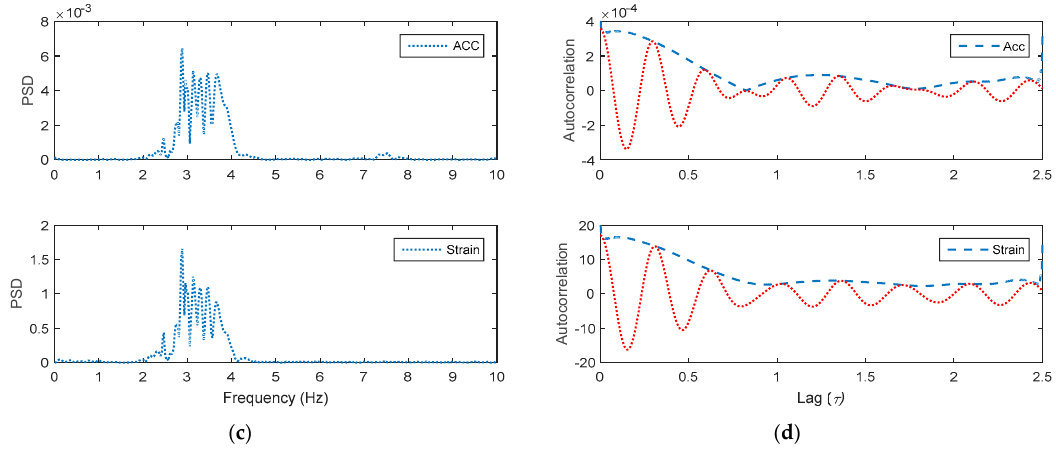
Figure 10. Frequency domain evaluation of ( a ) time–frequency, ( b ) time–phase, ( c ) fast Fourier transformation (FFT), ( d ) autocorrelation and damping ratio of the dynamic strain and acceleration.